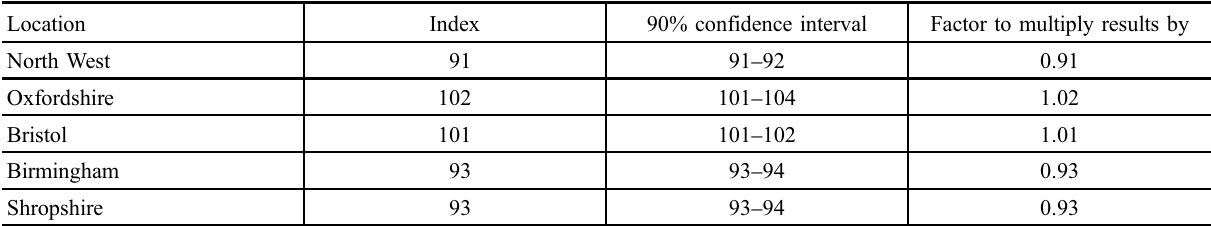
Table 2. Location indices from BCIS (2011) to rebase the data for the location factor (Base index is UK mean = 100)